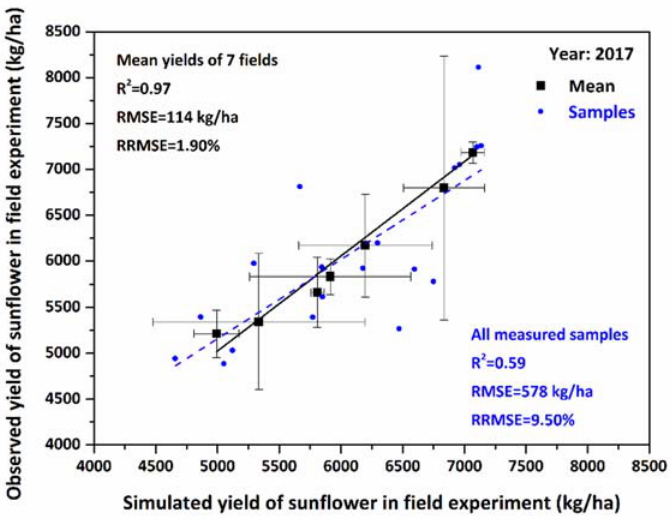
Figure 8. Evaluation of Equations (7)–(9) relative to observed yield in 2017. Black squares indicate the mean value of 7 fields, with standard deviations of both observed and simulated yields. Blue points indicate yields of all 21 measured samples. Black lines and blue dashed lines indicate the linear fitting curves of mean values and all measured samples, respectively.